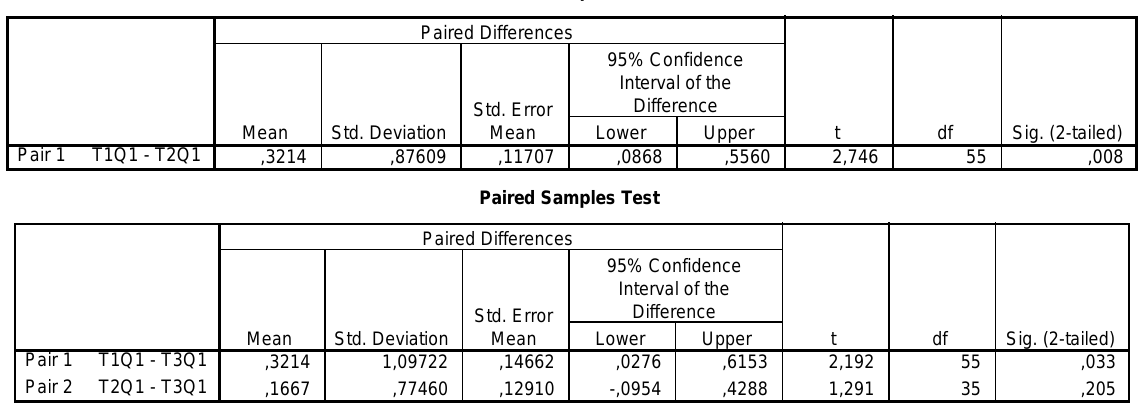
Self-Assessed Physical Health Significantly Improved with Clinical Holistic Medicine Paired Samples